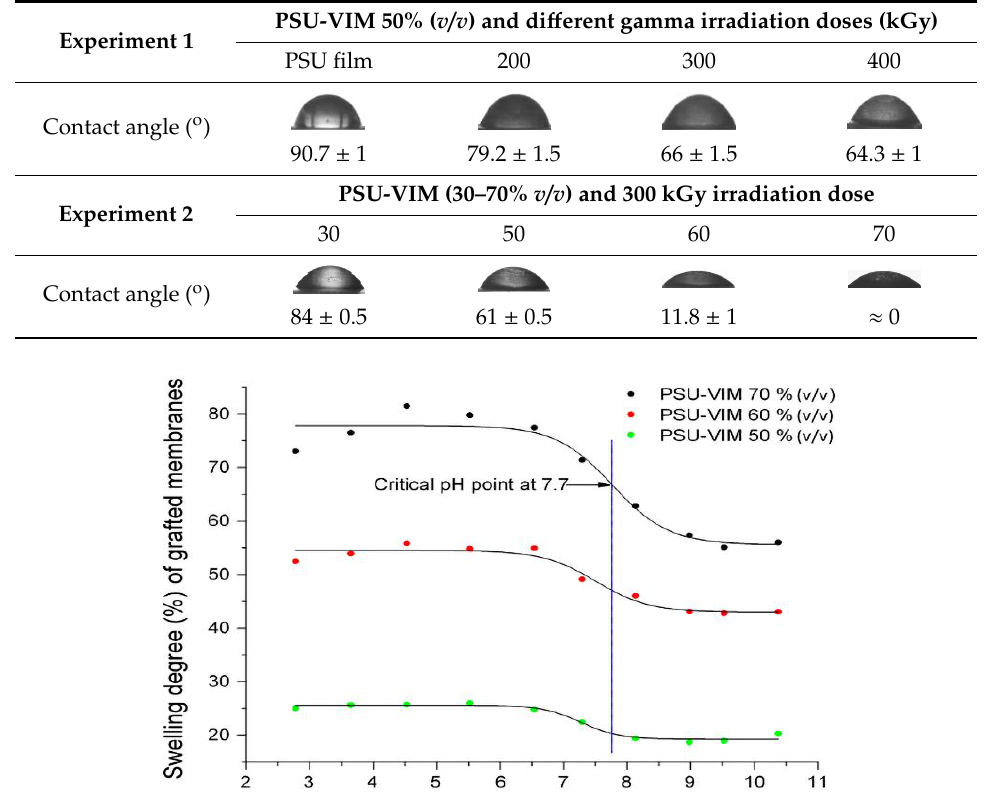
Table 1. Water contact angles of PSU membranes from experiments 1 and 2.